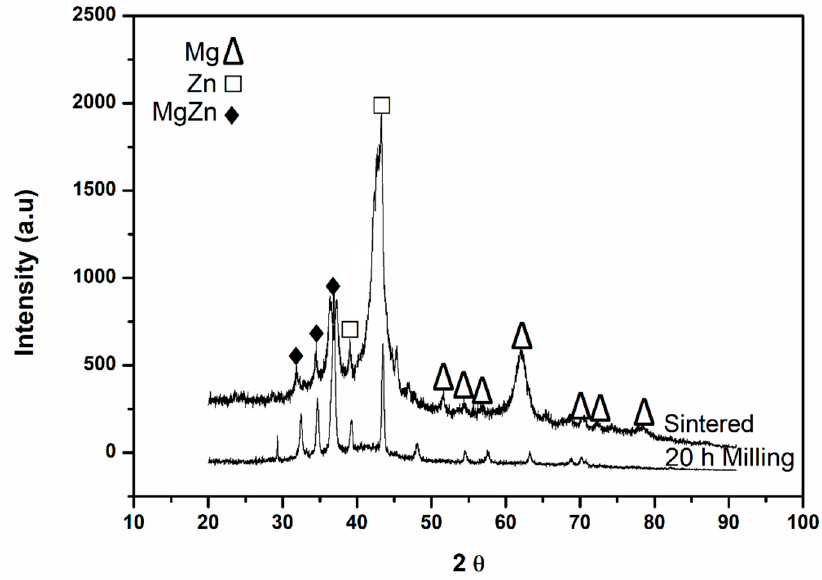
Figure 9. XRD patterns of the Mg70–Zn25–Ca5 obtained and the powders milled for 20 h.